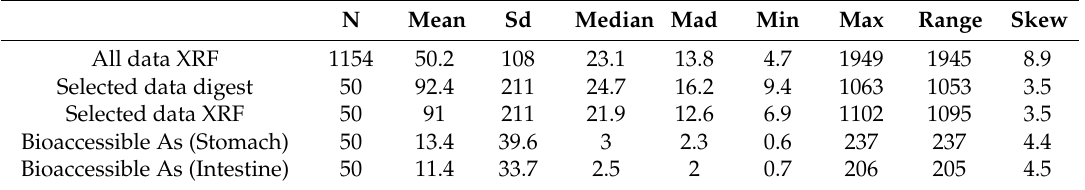
Table 1. Summary statistics for As (mg · kg − 1 ) in the entire data set and the selected samples. Table 1 . Summary statistics for As (mg·kg − 1 ) in the entire data set and the selected samples.